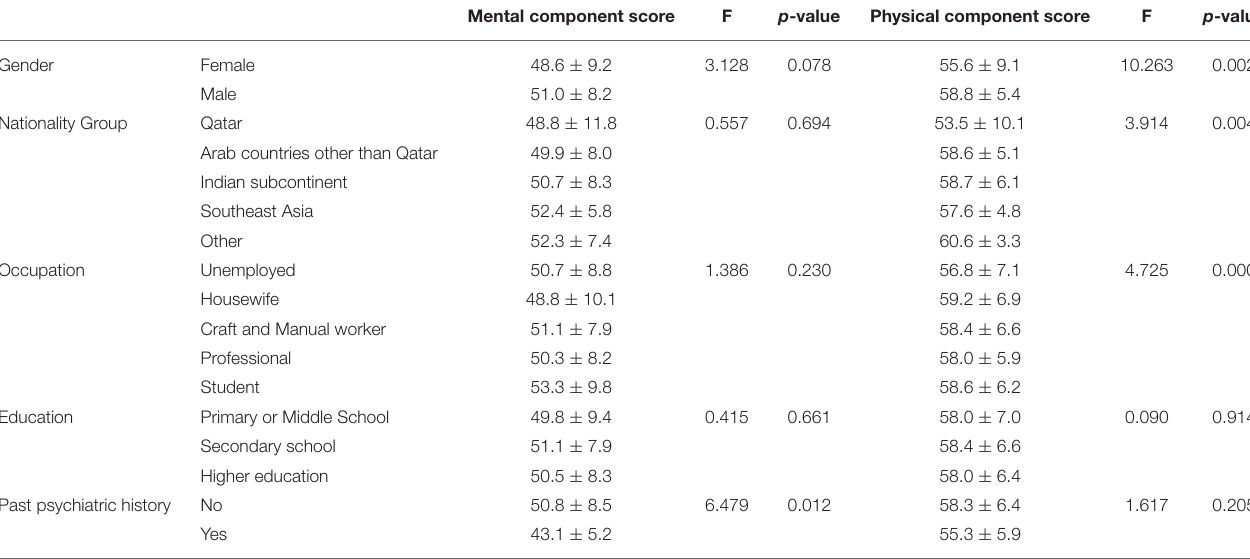
TABLE 2 | Factors associated with SF-36 component scores in patients with COVID-19 (either inpatient or quarantined).